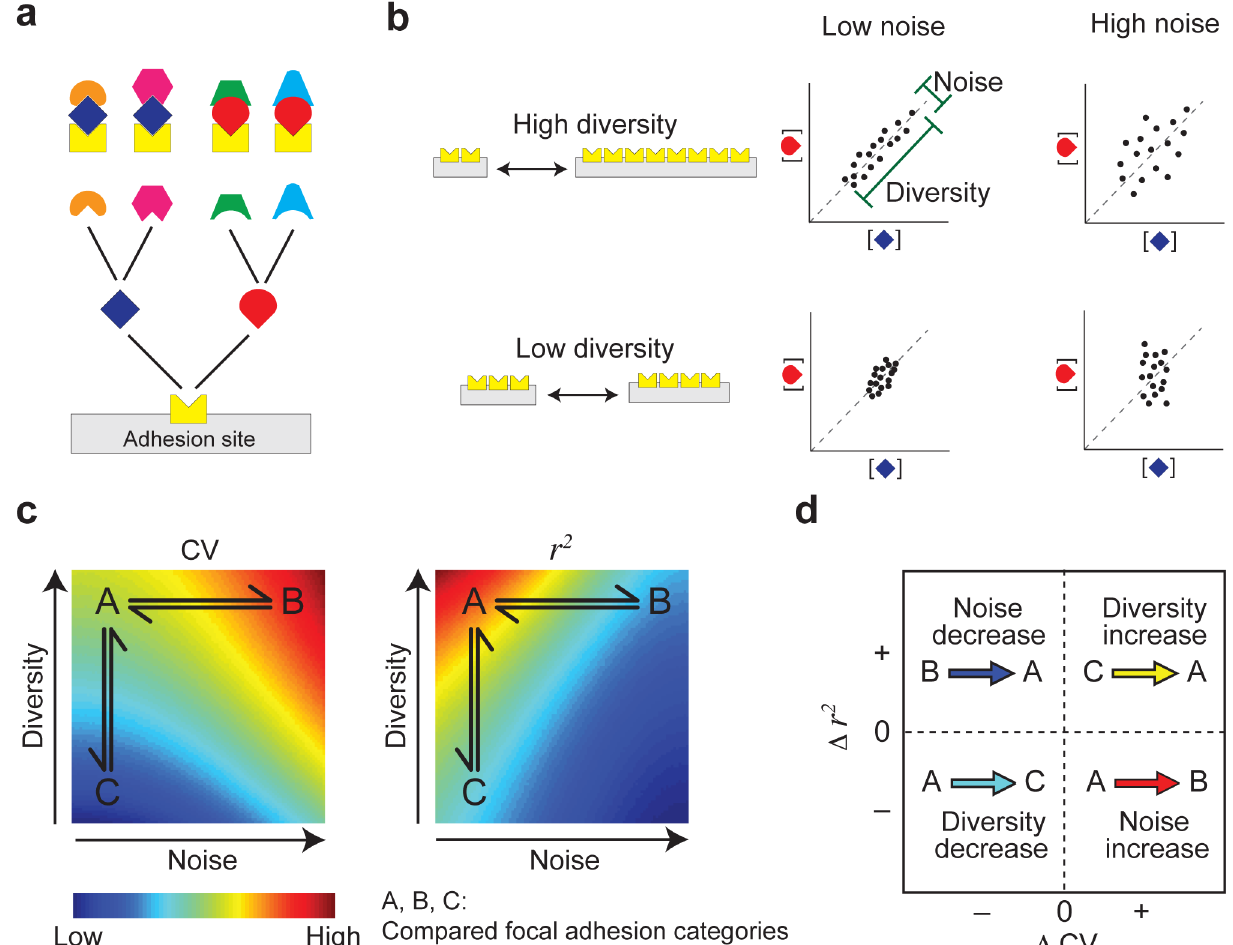
Fig 2. Inferring changes in noise levels in the molecular content of focal adhesions. (a) An assembly process with competing binding interactions. (b) Higher diversity in the local levels of a recruiting protein leads to a stronger correlation between the recruited proteins, while higher noise causes the opposite. (c) Simulated CV and r 2 of the densities of the dark-blue and red components as a function of binding noise and diversity in the density of the yellow component among focal adhesions. (d) Inferring changes in noise levels based on Δ CV and Δ r 2 . Changes between focal adhesion categories exemplified in (c) are indicated. The inference approach was validated by systematic screen of diversity and noise levels for competitive and non-competitive assembly